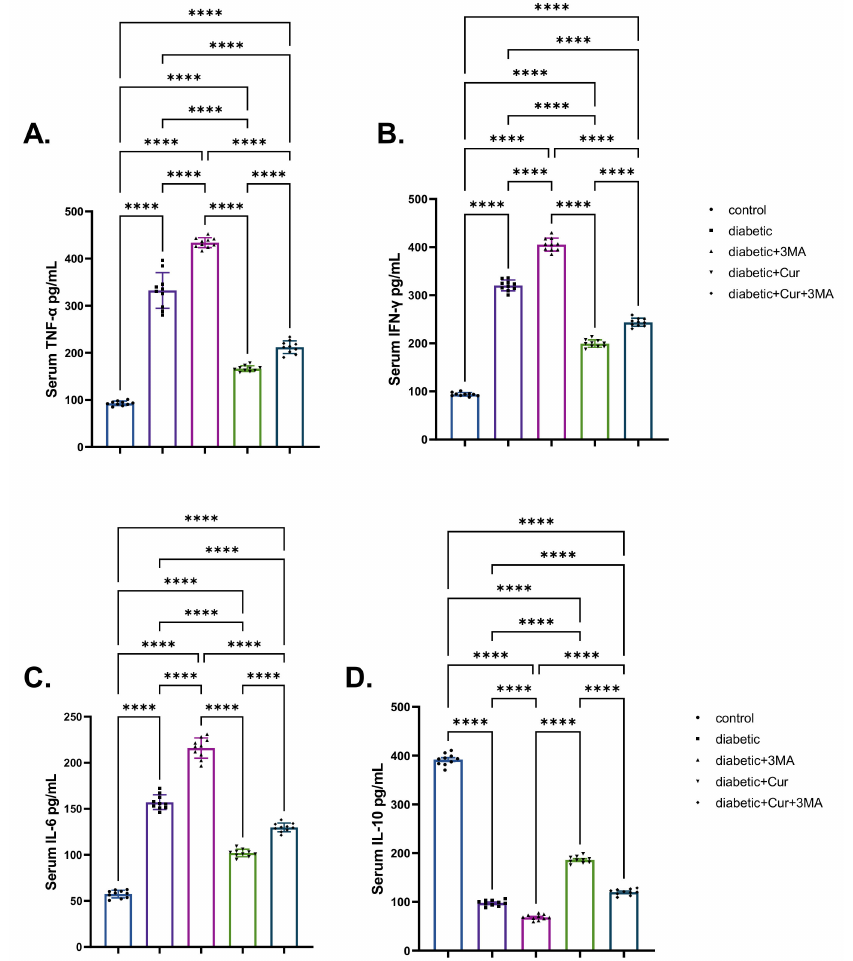
Figure 4. Effect of diabetes (STZ) (65 mg/kg b.wt), 3MA (10 mg/kg b.wt), LPs-CUR (10 mg/kg b.wt.) oral dosing for ten weeks on serum levels of pro-inflammatory cytokines ( A ) TNF- α , ( B ) IFN-Y, ( C ) IL-6, ( D ) IL-10 of all diabetic and vehicle control groups. Data expressed as mean ± SE, n = 10 for each group. Each bar carries the significance, which may be significance which may be significant at **** p <